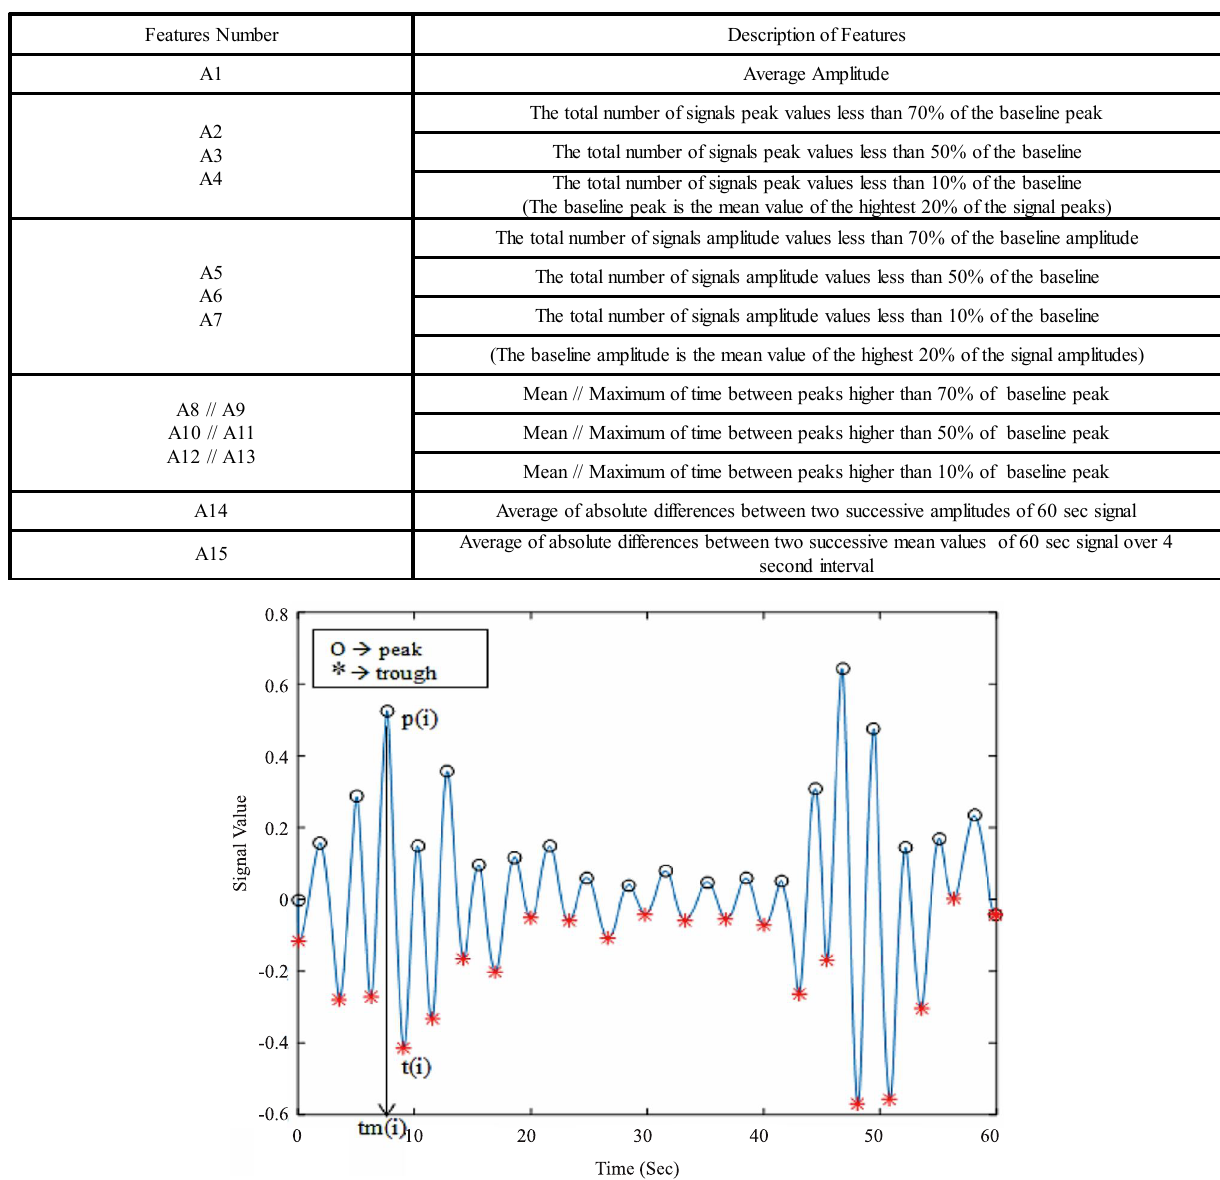
TABLE 2. SET-2: AMPLITUDE FEATURES